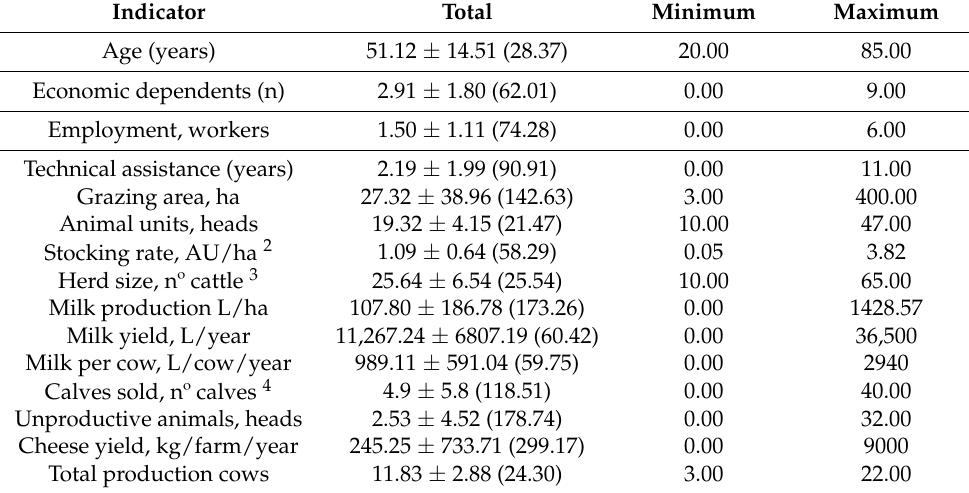
Table 1. Structural characteristics of dual-purpose cattle farms (n = 383) (Mean ± SD (CV, %) 1 ).